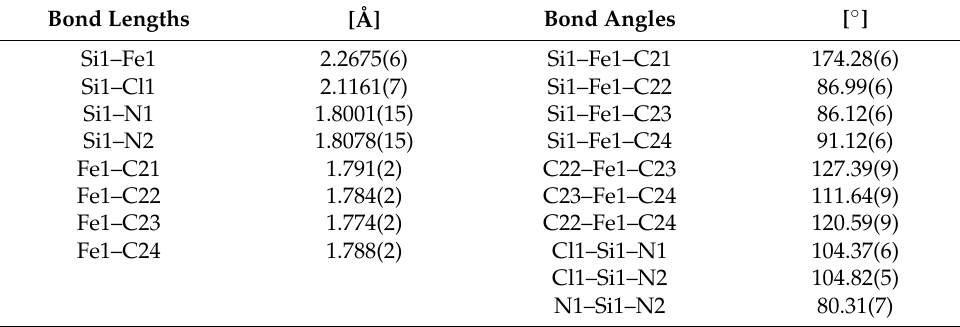
Table 1. Selected bond lengths [Å] and bond angles [ ◦